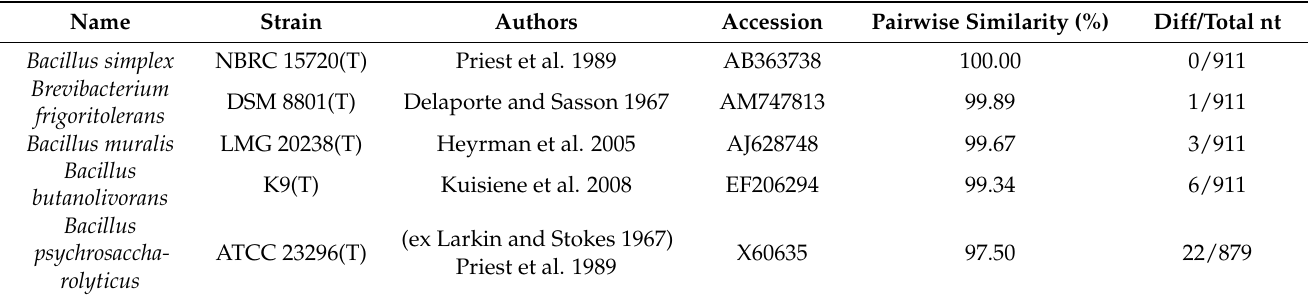
Table 5. Phylogenetic identification of closely related bacteria to the studied strain (911 nt) Bacillus simplex